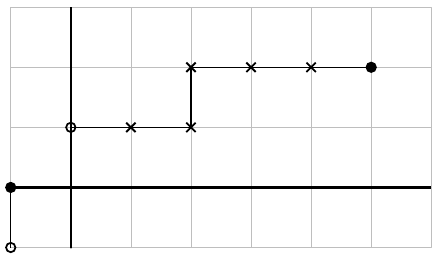
Figure 6. The structure of zeros and poles of the generating function ( u ) for the fundamental representation in direction h 3 of Y 5 ; 2 ; 0 [(cid:9)]. We draw one example of the snake con(cid:12)guration.